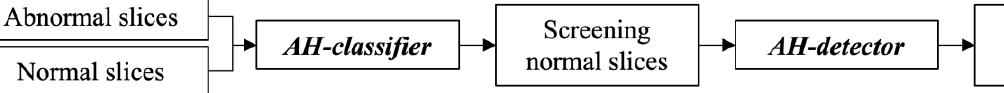
Figure 4. The structure of the improved neural network for small lesion detection.